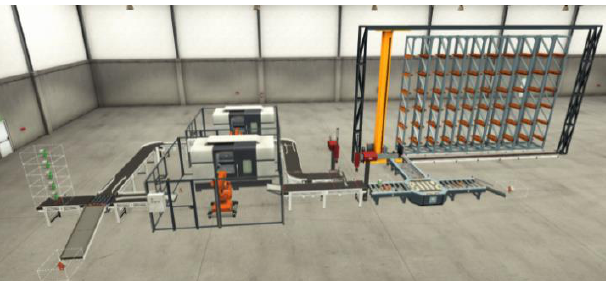
Figure 5. Cyber factory scene.